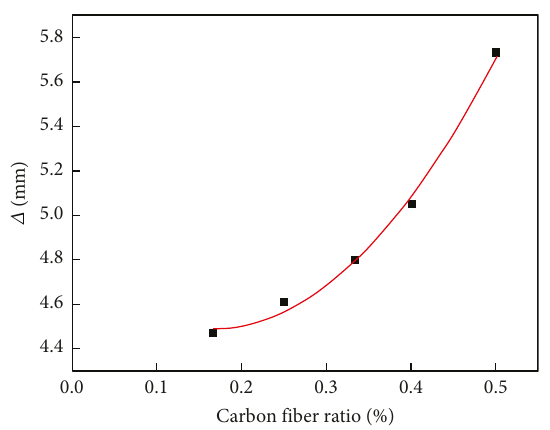
Figure 9: Axial deformation of specimens with different carbon fiber ratios.